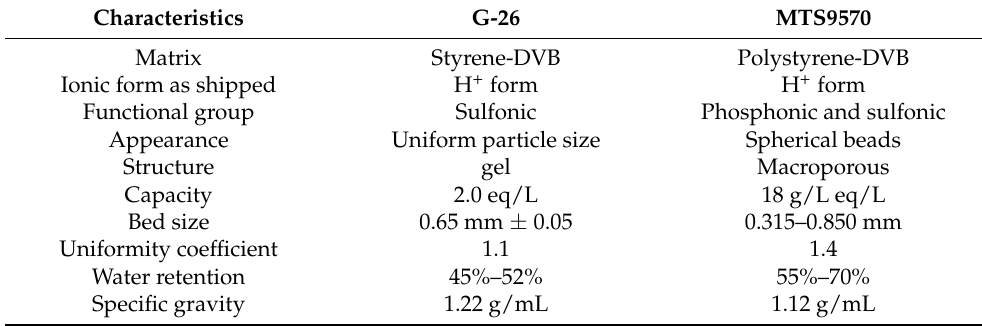
Table 1. Physical and chemical properties of resins